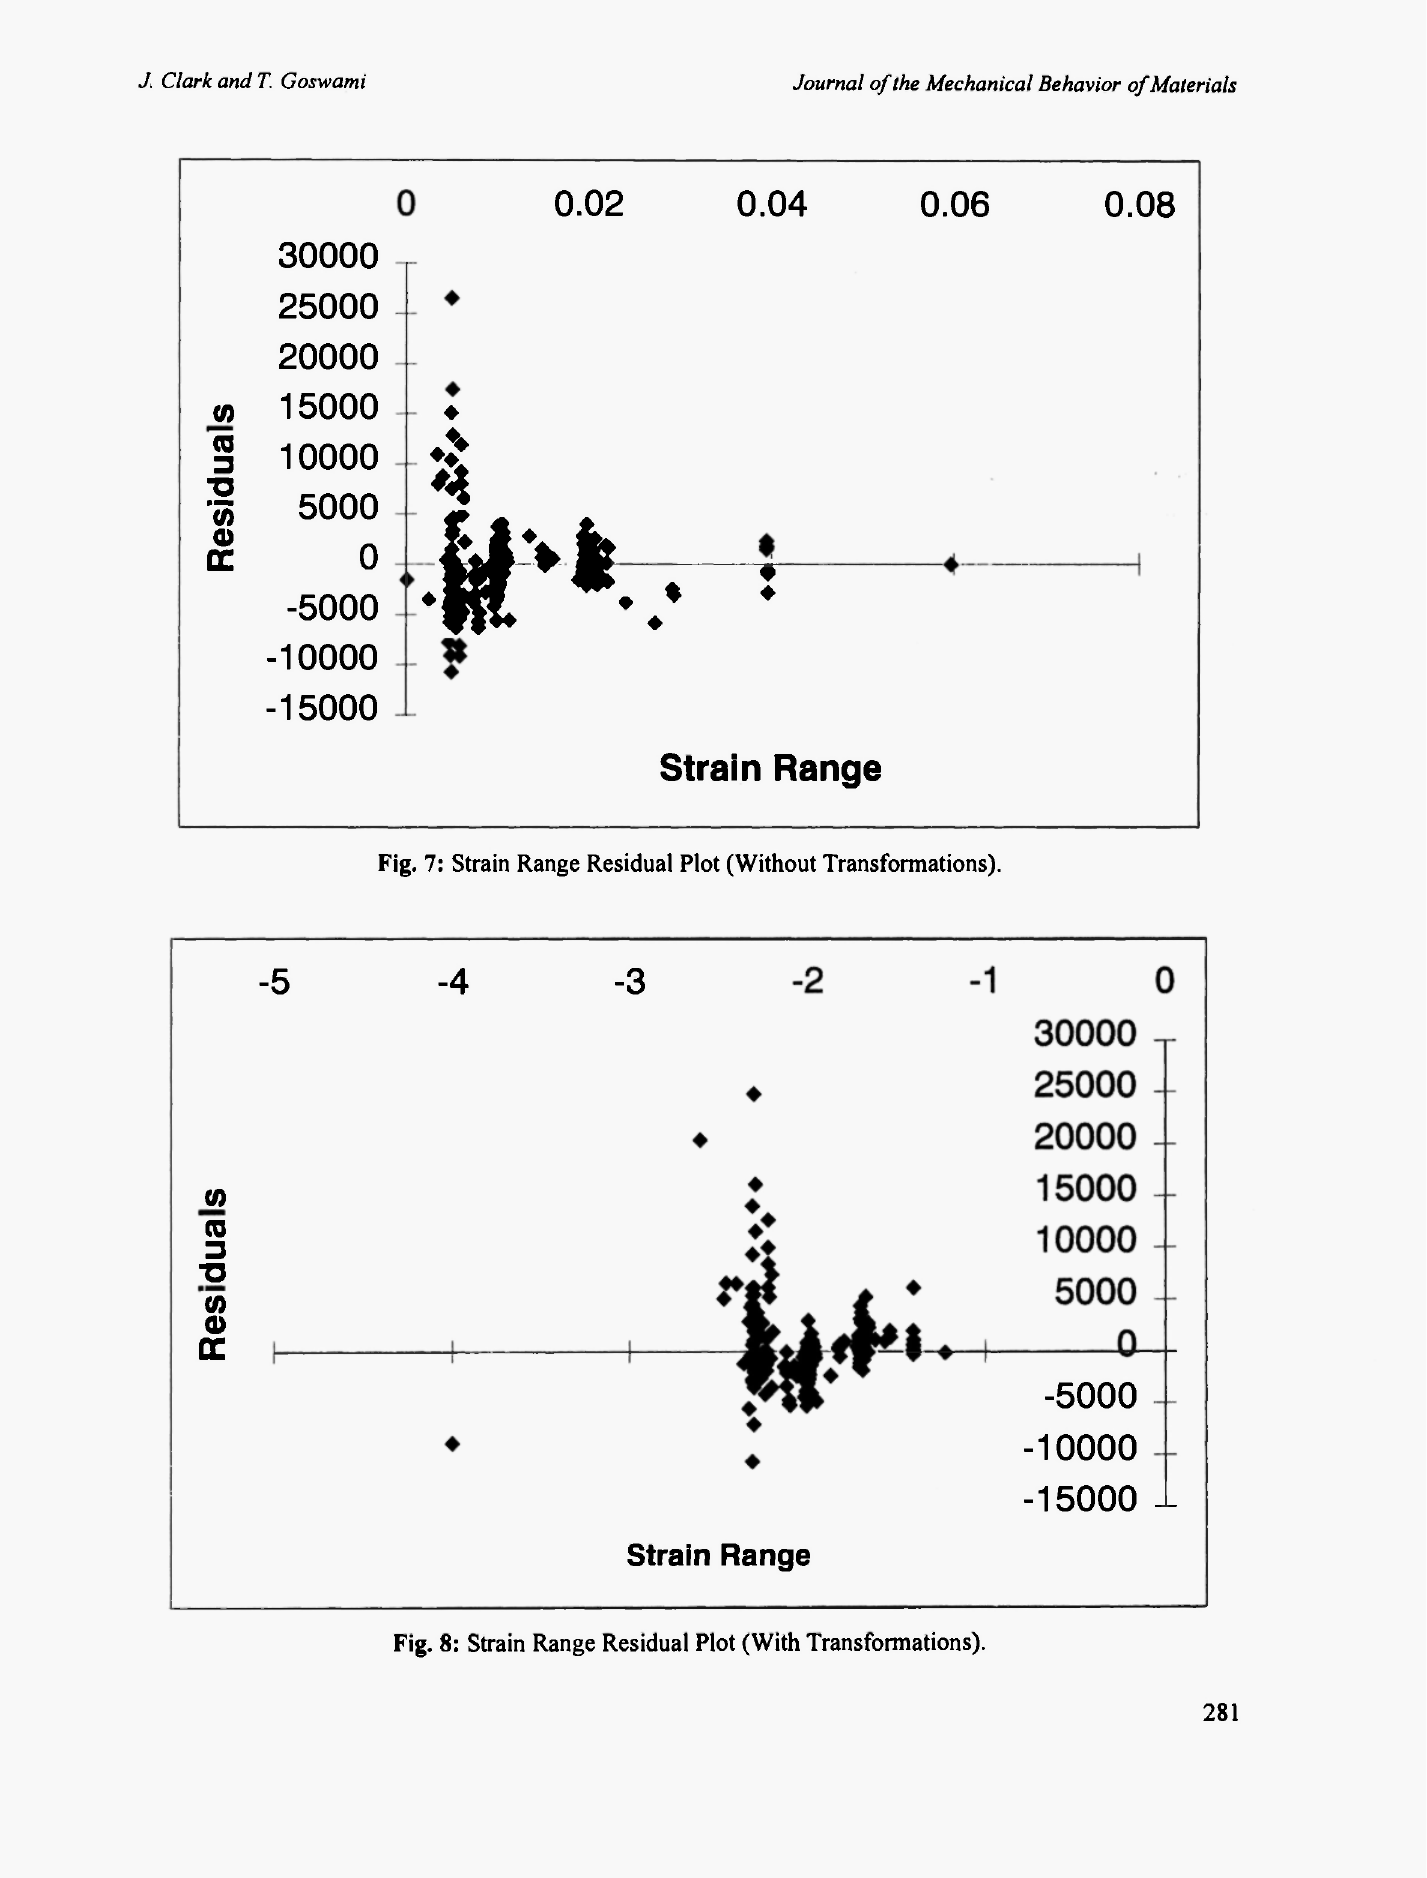
Fig. 8: Strain Range Residual Plot (With